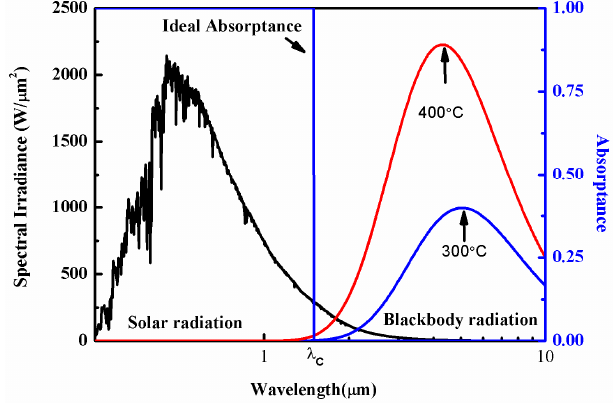
Figure 1. Solar radiation and blackbody radiation spectra.